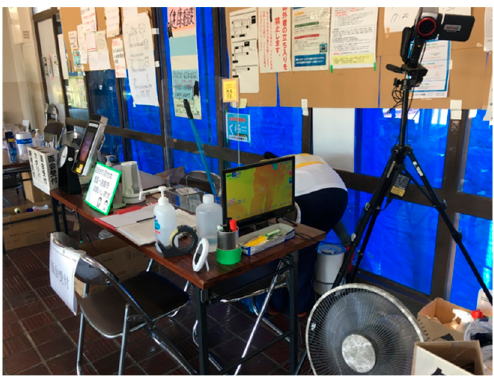
Figure 5. Hand sanitizer and thermography at the registration tables.